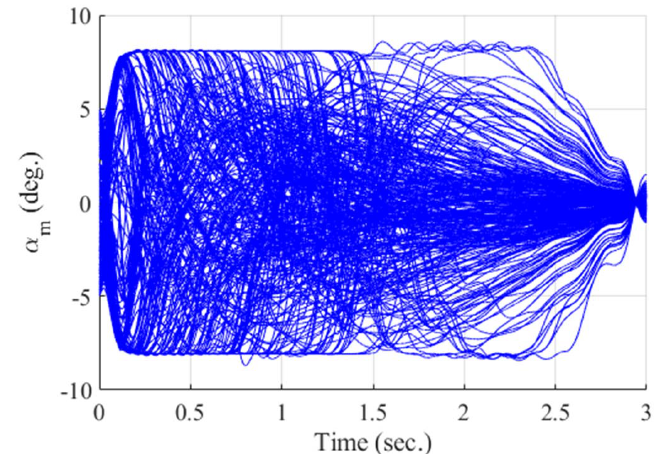
Figure 16. Angle of attack of the missile (Monte Carlo simulation).